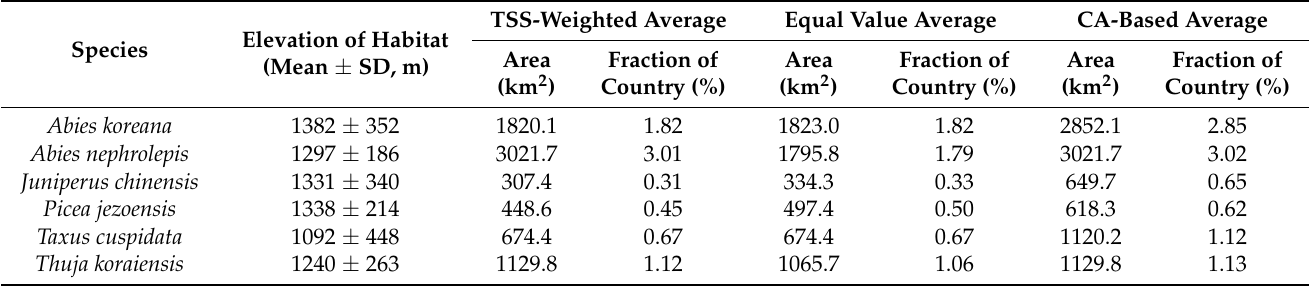
Table 4. Currently suitable habitat areas for subalpine forest species in Korea using true skill statistic (TSS) weighted average, equal average, and committee averaging (CA)-based ensemble averaging